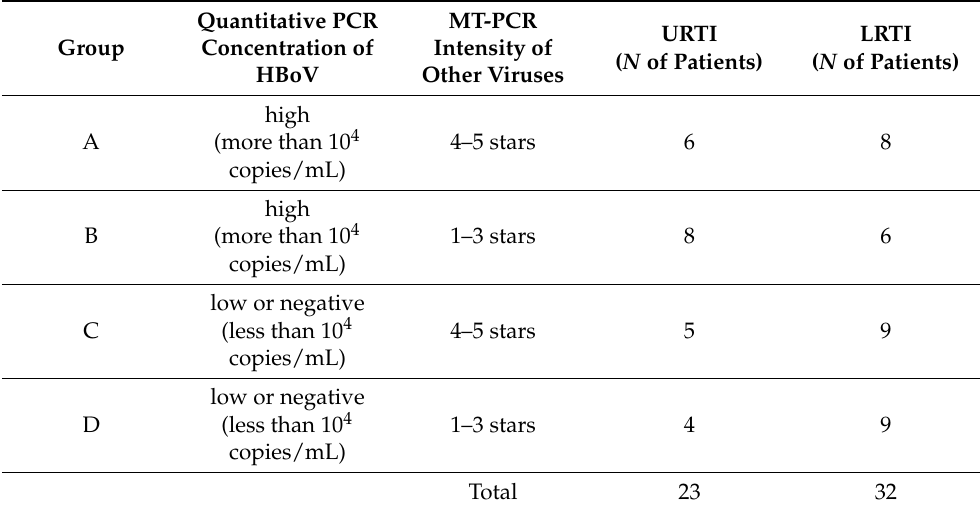
Table 3. Patients divided in four groups according to amount of HBoV and other respiratory viruses, and localization of infection in the respiratory tract (UTRI—upper respiratory tract infection, LRTI—lower respiratory tract